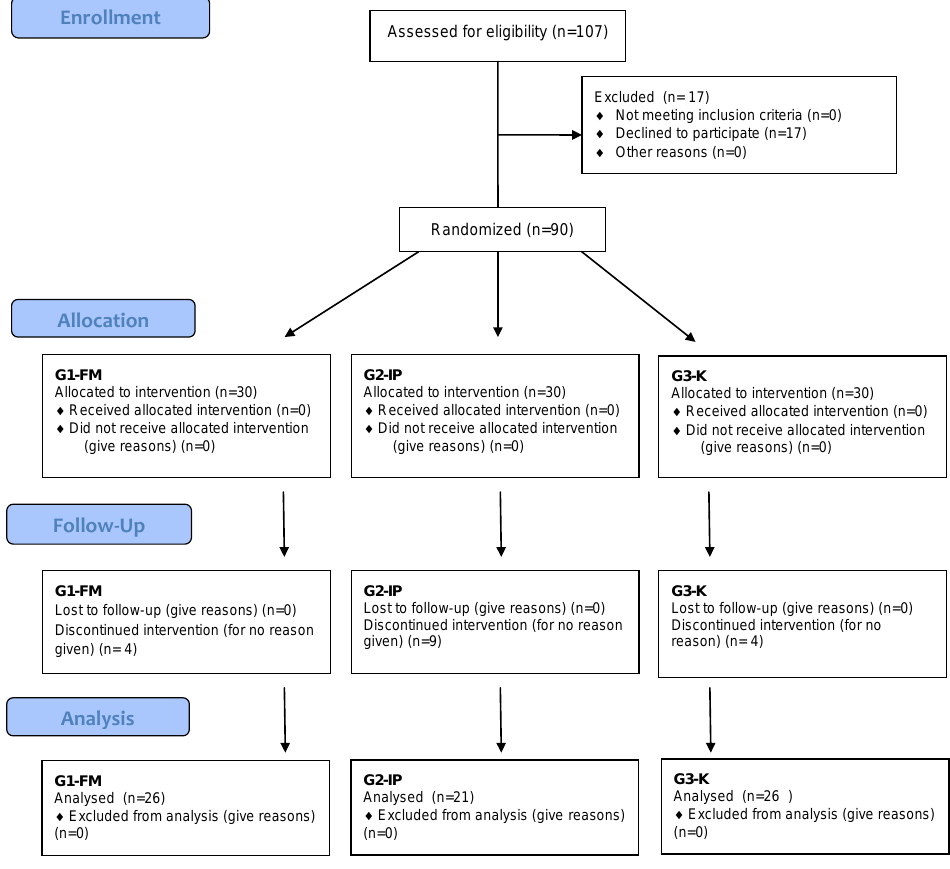
Figure 1. Randomization